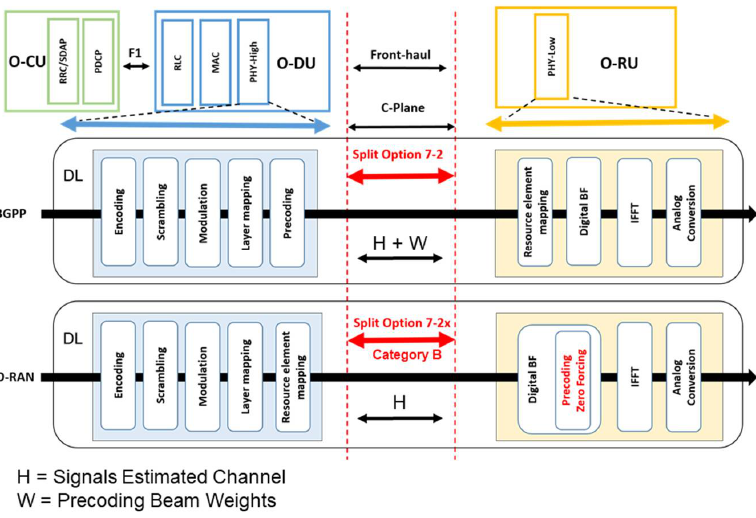
Figure 6. Digital beamforming block diagram in 3GPP and O-RAN.